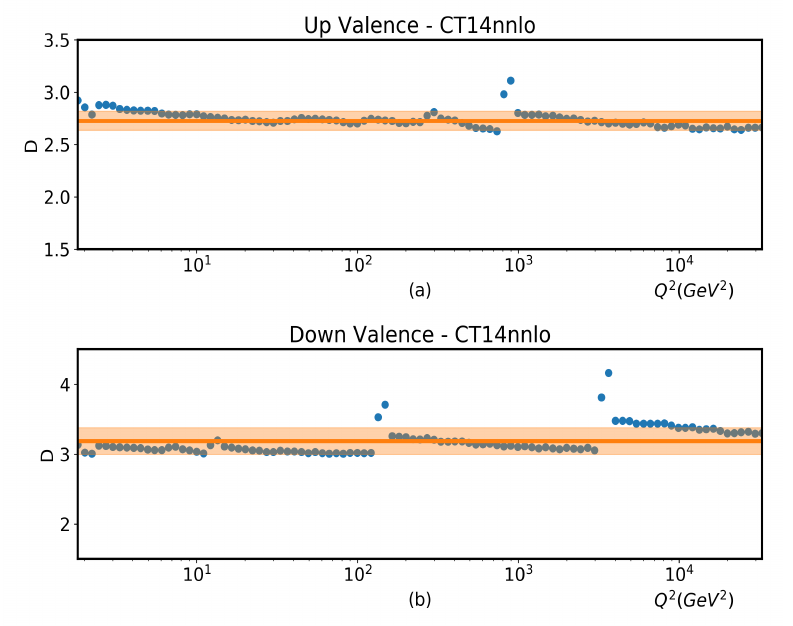
Figure 3. Same as Figure 2 but for next-to-next leading order approximation for CT14 PDFs [3] for valence u-quark ( a ) and d-quark ( b ) distributions. The thick orange line is the D obtained from averaging all the D for the central value curve, while the shaded orange region shows the region within 1 σ of the average. Table 1 contains the PDF propagated errors.